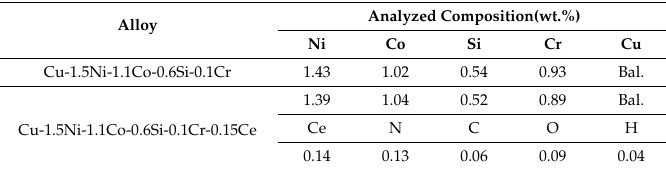
Table 1. The nominal and analyzed compositions of the alloys. Alloy Analyzed